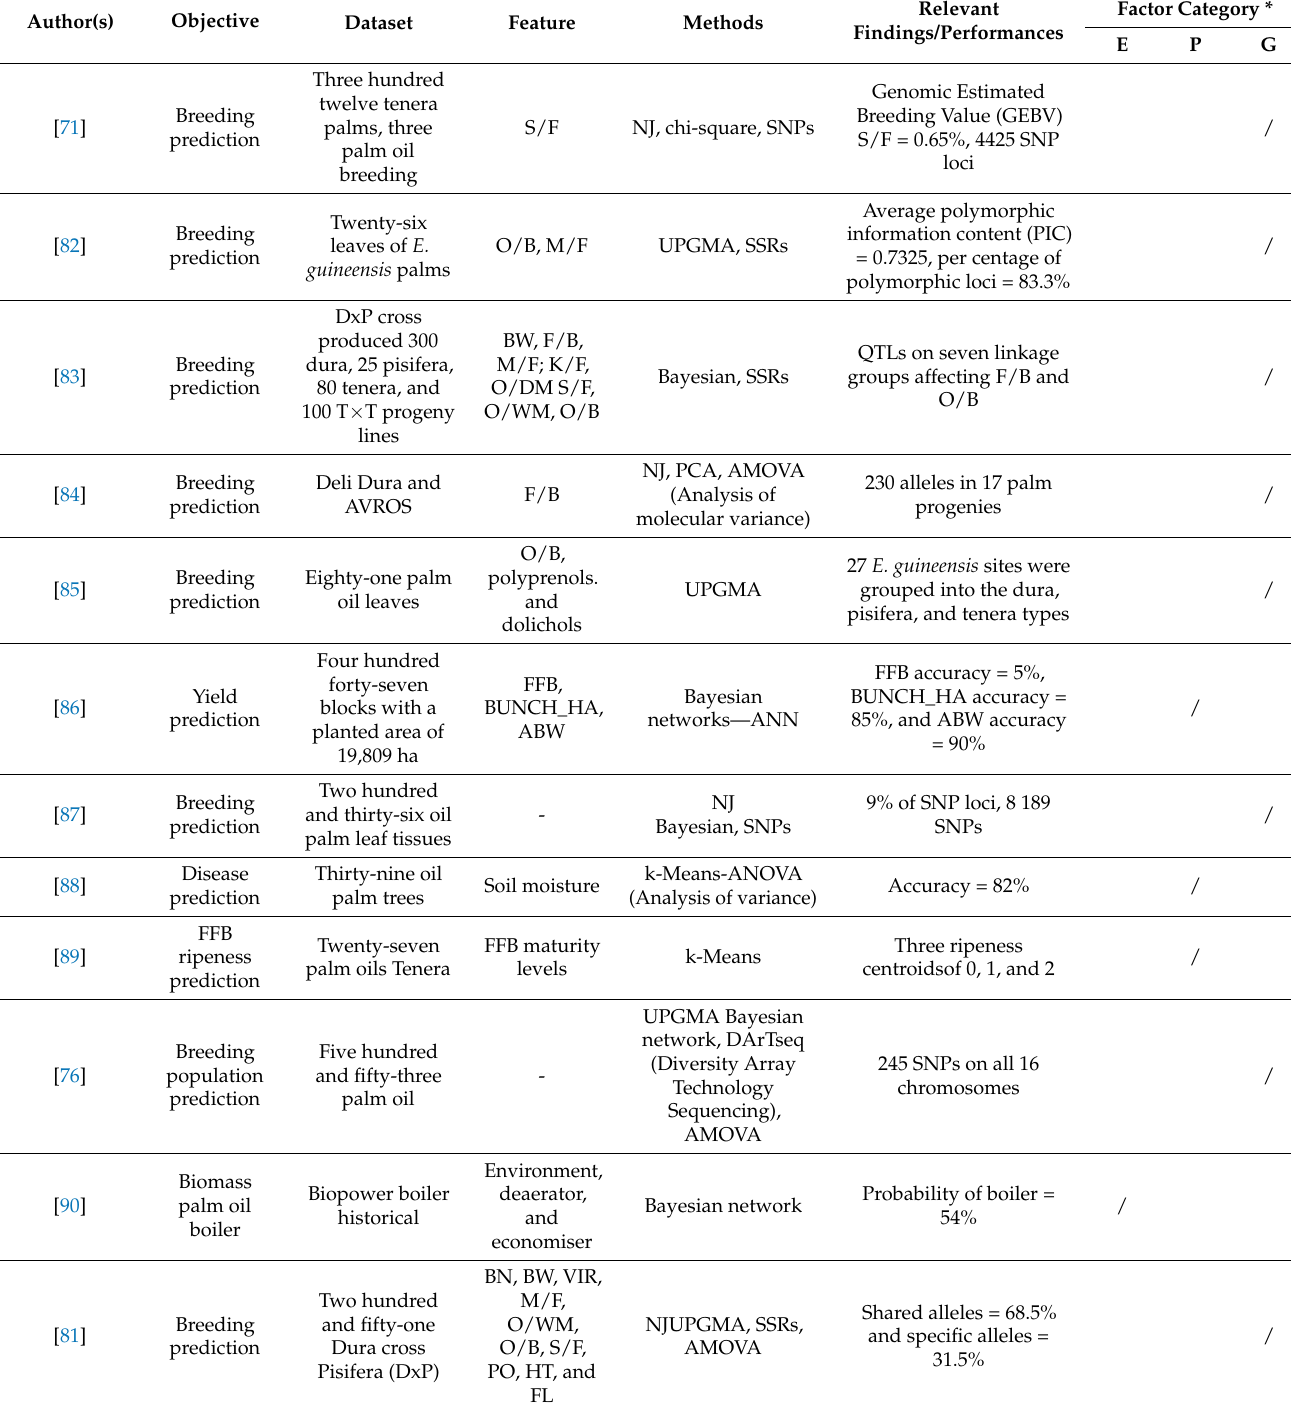
Table 3. Unsupervised prediction of palm oil